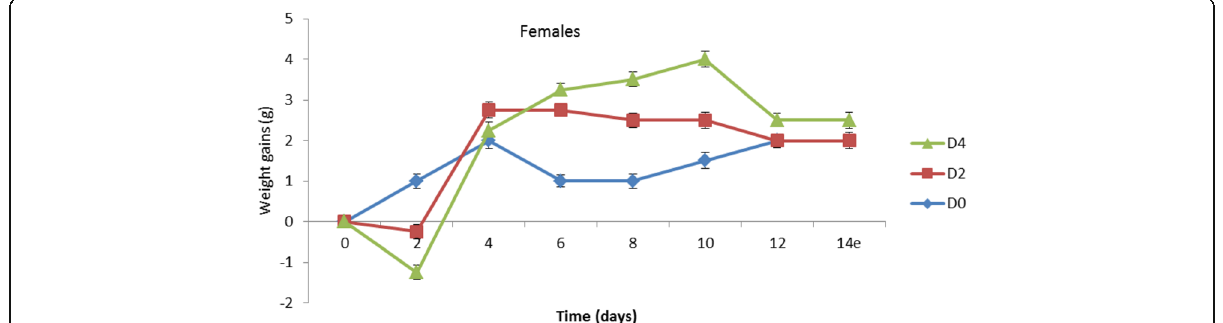
Fig. 2 Trends in mean body weight gains of female mice after single dose oral administration of A. cordifolia leaves extract. D0 = distilled water, D2 = 2 g/kg, D4 = 4